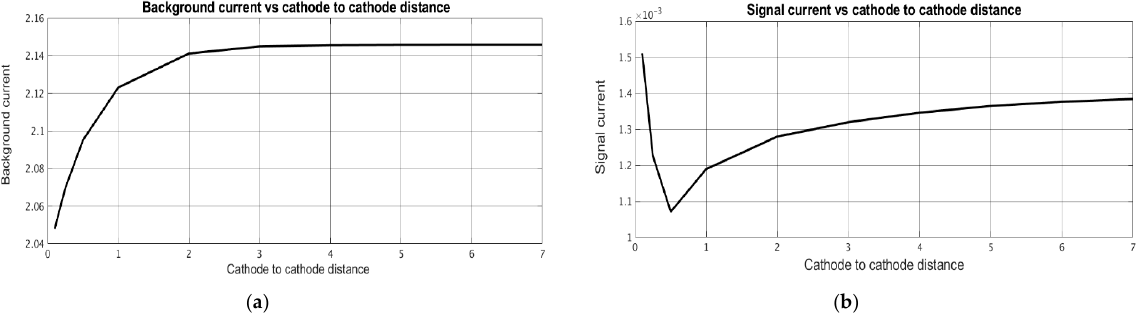
Figure 10. Dependence of ( a ) stationary background current and ( b ) signal current on the dimensionless distance between cathodes.